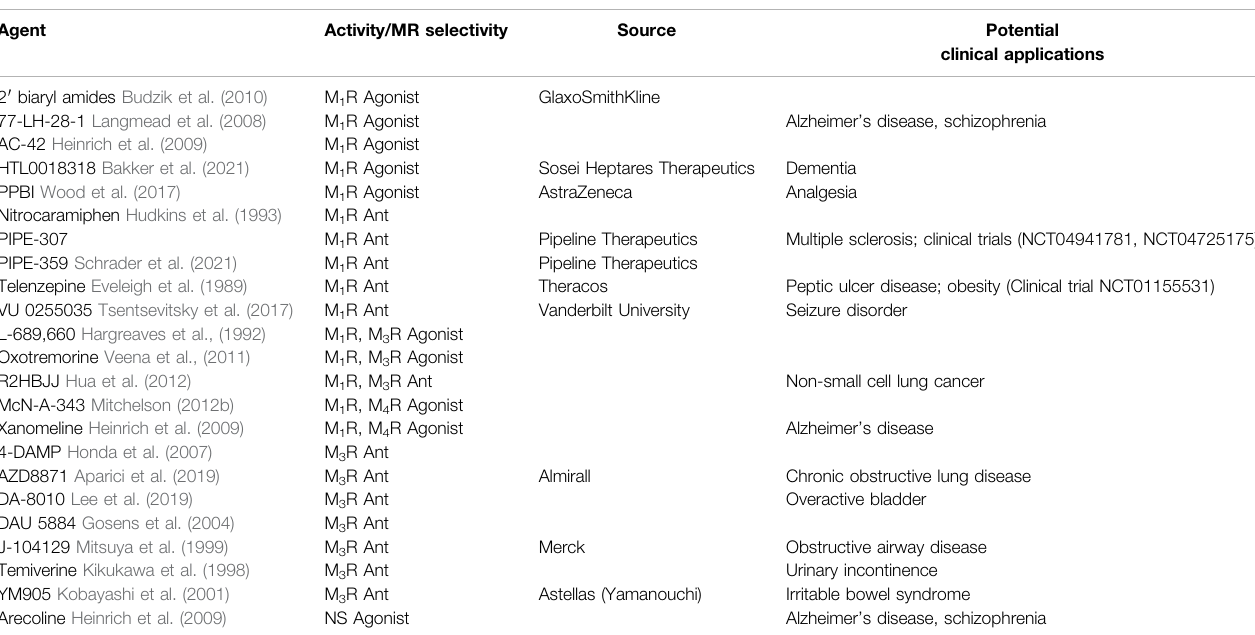
TABLE 2 | Selective M 1 R/M 3 R agents used for research and under clinical